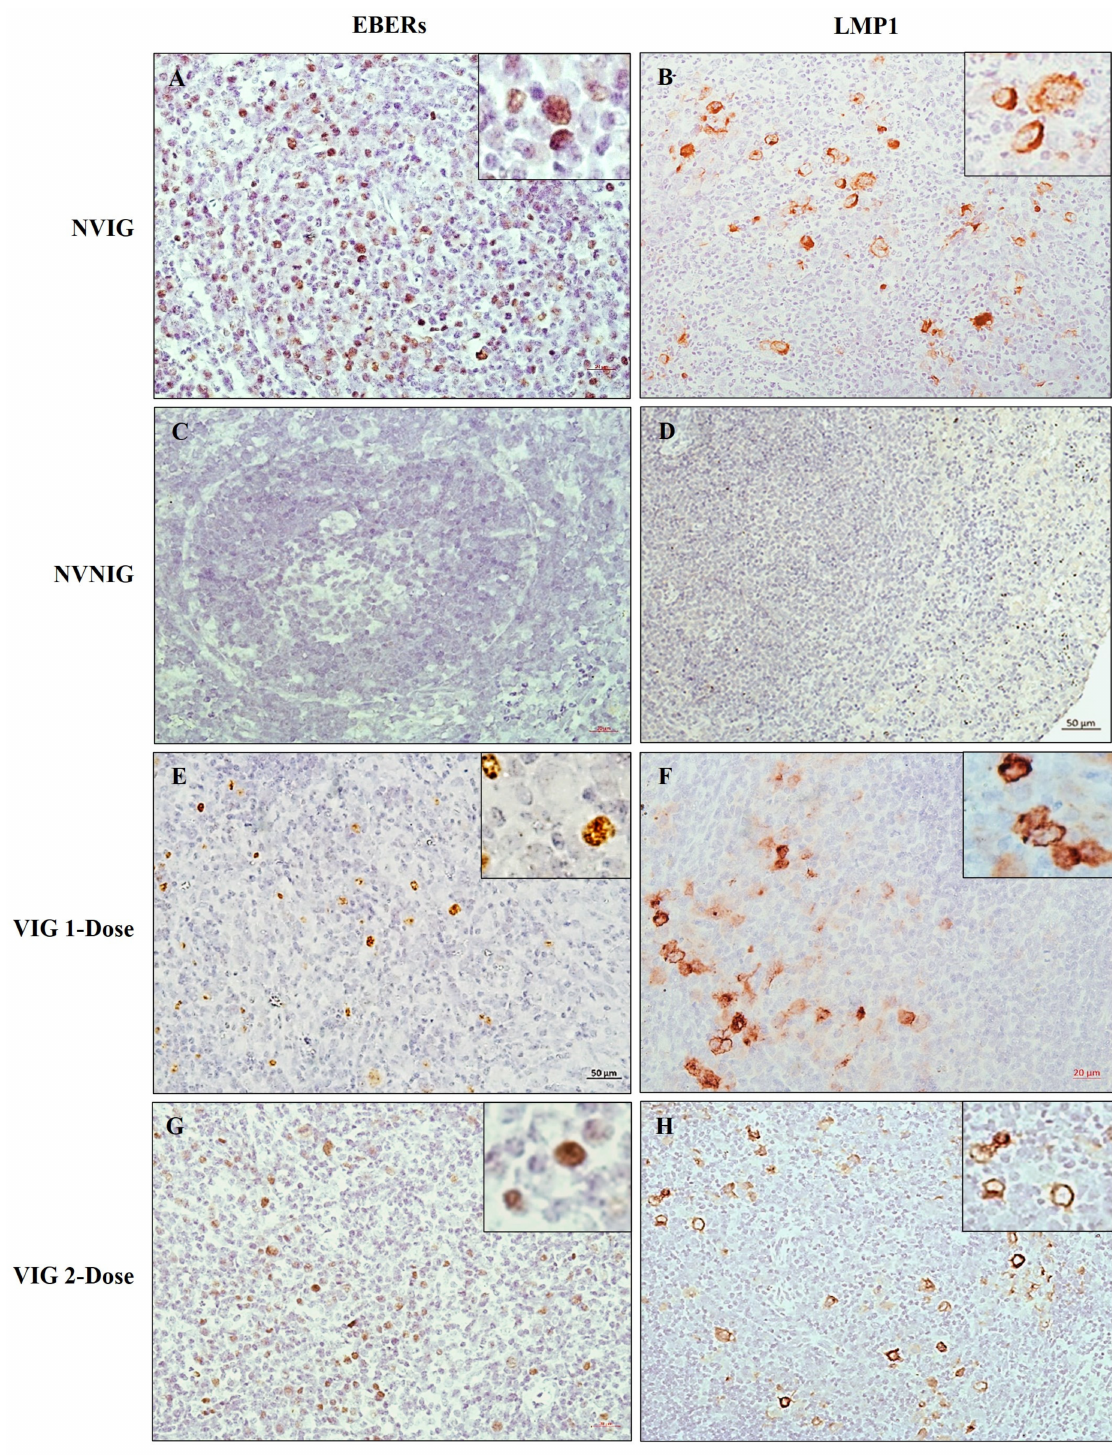
Figure 3. Detection of EBV and its gene expression in rabbit spleen. EBER-in situ hybridization was used to detect EBERs, and immunohistochemistry was used to detect the expression of LMP-1. Rabbits in the non-vaccinated, infected group (NVIG) were clearly positive for both EBERs ( A ) and for LMP1 expression ( B ), whilst the non-vaccinated, non-infected control (NVNIG) animals were negative for both ( C , D ). Animals vaccinated with either 1-dose of the VLP vaccine ( E , F ) or 2-doses ( G , H ) and subsequently challenged with EBV were not protected from infection. The spleens in animals from both groups were positive for EBERs and